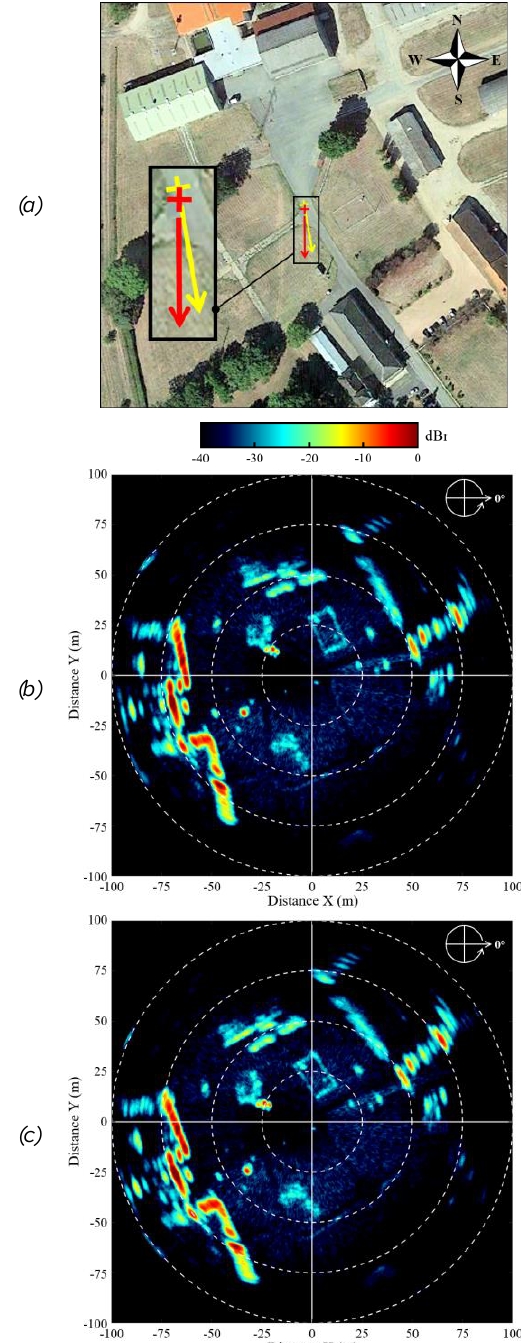
Figure 4. Example of two successive corrected radar images. (a) North-oriented aerial image of the test zone. Yellow/red crosses and arrows: successive positions and orientations of the robot. (b), (c) Successive radar images in Cartesian coordinates. Time interval, displacement and orientation change between images: 1 s, 2.1 m and 10°.